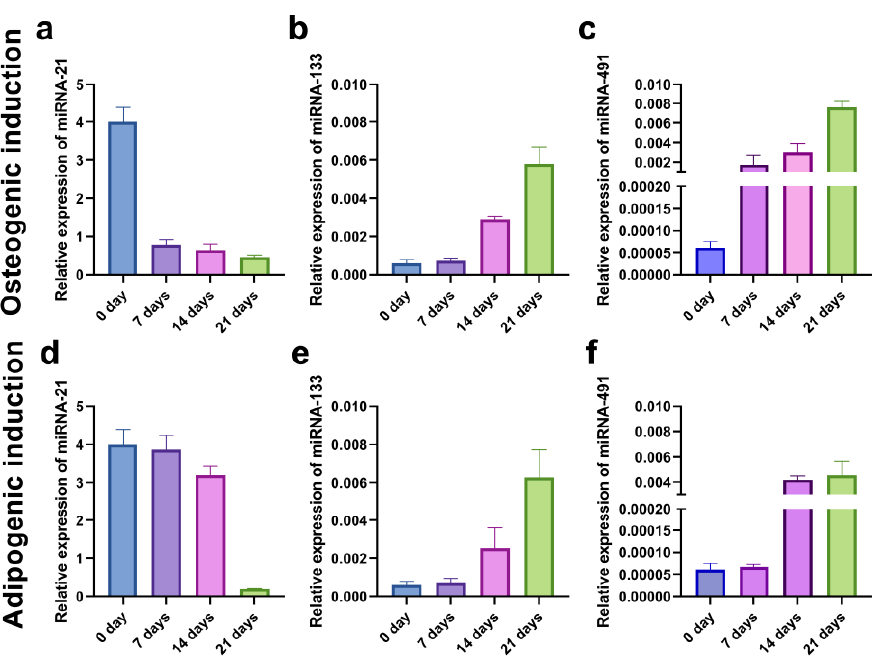
Figure 14. qPCR analysis of relative miRNA-21 ( a , d ), miRNA-133 ( b , e ), and miRNA-491 ( c , f ) expressions in CD44 + cells from the SCC-25 during 21 days of osteo-induction ( a – c ) and adipo-induction ( d – f ).